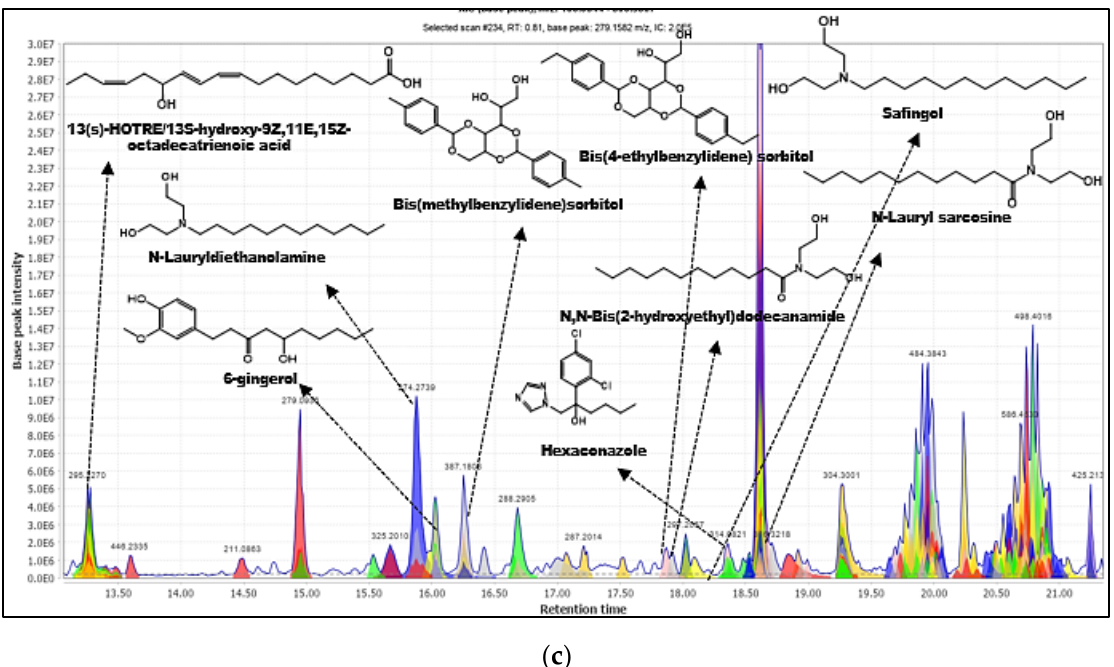
Figure 6. Annotated metabolites from CD based on TIC chromatogram. ( a ) retention time 0–6 min, ( b ) retention time6–15 min, ( c ) retention time-13–22 min.